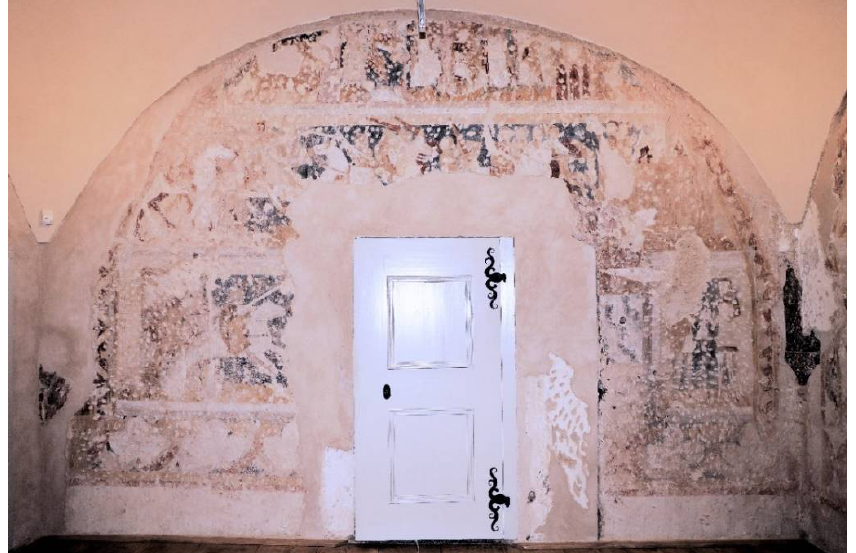
Figure 20. Kunštát, castle. The northern wall of the room with the knight’s cycle (probably the Knight’s Ride of Gahmuret with the Battle of Batellamunt). 1st half of the 14th century. Photo by František Záruba, the author’s own work.